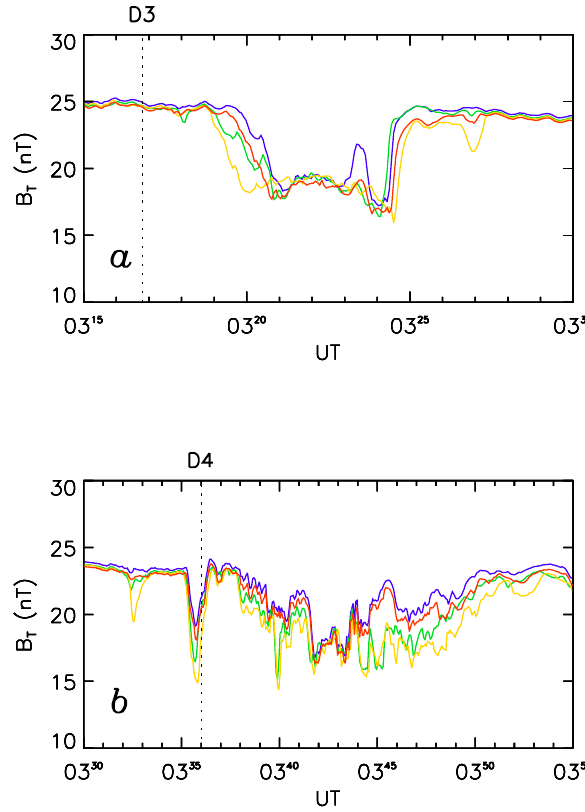
Fig. 12. Total magnetic field strength B T from all four Cluster spacecraft for the intervals (a) 03:15 to 03:30 UT, and (b) 03:30 to 03:55 UT, 29 August